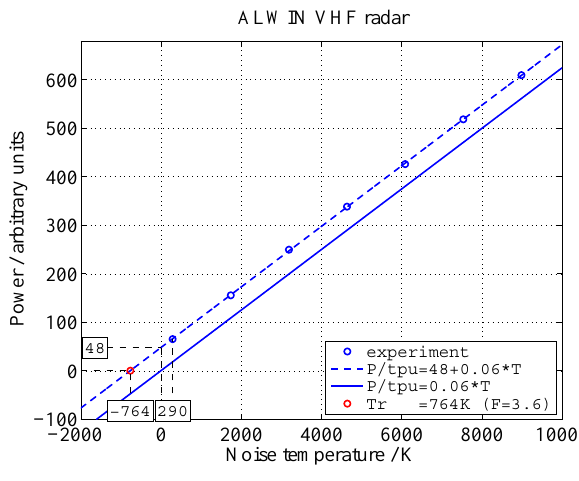
Fig. 3. Calibration with a noise source: noise power in arbitrary units vs. noise temperature. The red circle represents the receiver noise